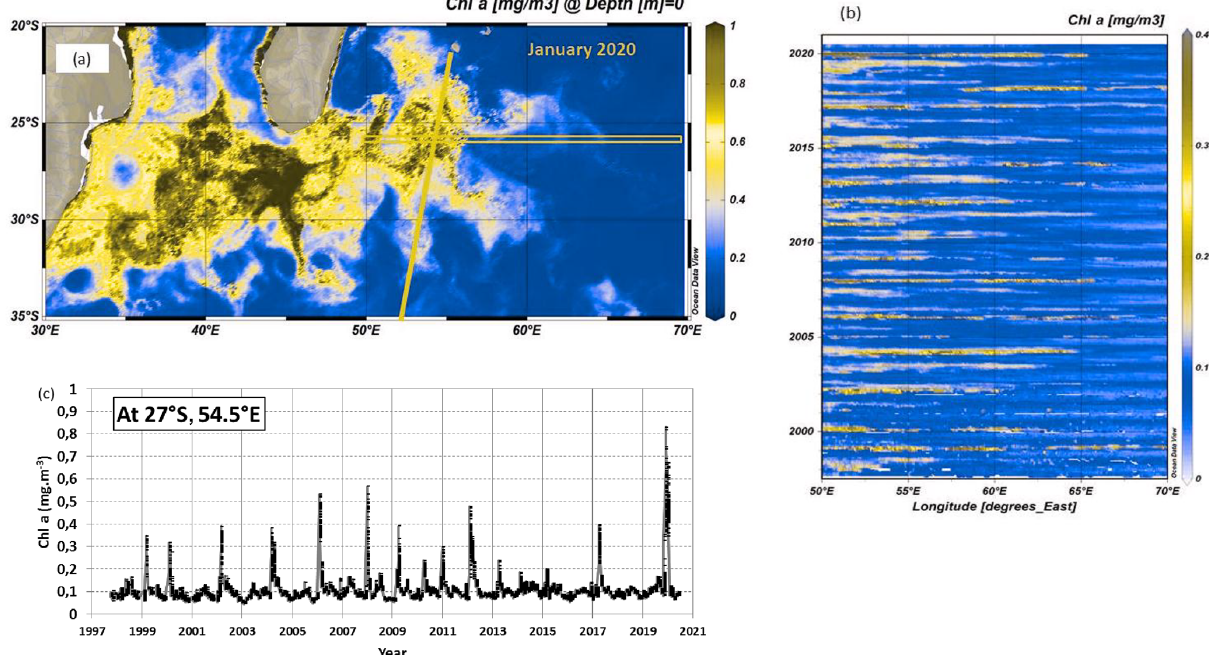
Figure 1. (a) Map of monthly surface Chl a (mgm − 3 ) in the south-western Indian Ocean in January 2020 derived from MODIS data (4km × 4km resolution), highlighting the bloom south and south-east of Madagascar. (b) Hovmoller time series (time and longitude) of Chl a (mgm − 3 ) around 26.5 ◦ S along 50–70 ◦ E (orange box in a ). (c) Time series of monthly Chl a (mgm − 3 ) at 27 ◦ S, 54.5 ◦ E (only when the valid number of pixels is greater than five for each point). The orange line on the map identifies the track of the OISO-30 cruise. The figures highlight the high Chl a concentration in austral summer 2020. Panels (a) and (b) produced with ODV (Ocean Data View; Schlitzer, 2013) from data downloaded from https://resources.marine.copernicus.eu/ (OCEANCOLOUR_GLO_CHL_L4_REP_OBSERVATIONS_009_093, last access: 10 April 2021).